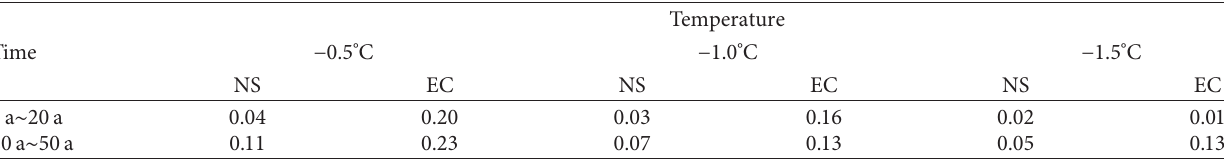
Table 2: The change rate of the permafrost table beneath the NS and CE under different mean annual ground temperatures (unit: m/a).